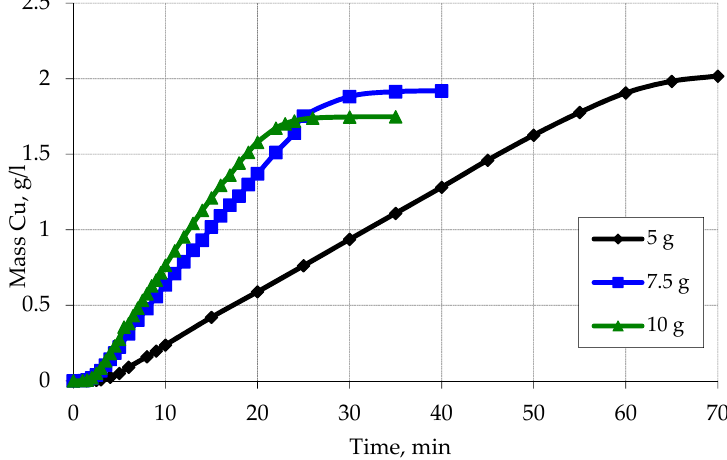
Figure 12. Kinetic curves of reduction of copper ions on the activated surface of polypropylene for the fraction of 0.7 depending on the degree of its loading. Concentration (mmol / L): CuSO 4 –48; NaOH–560; EDTA-Na 2 –67; formaldehyde–366.